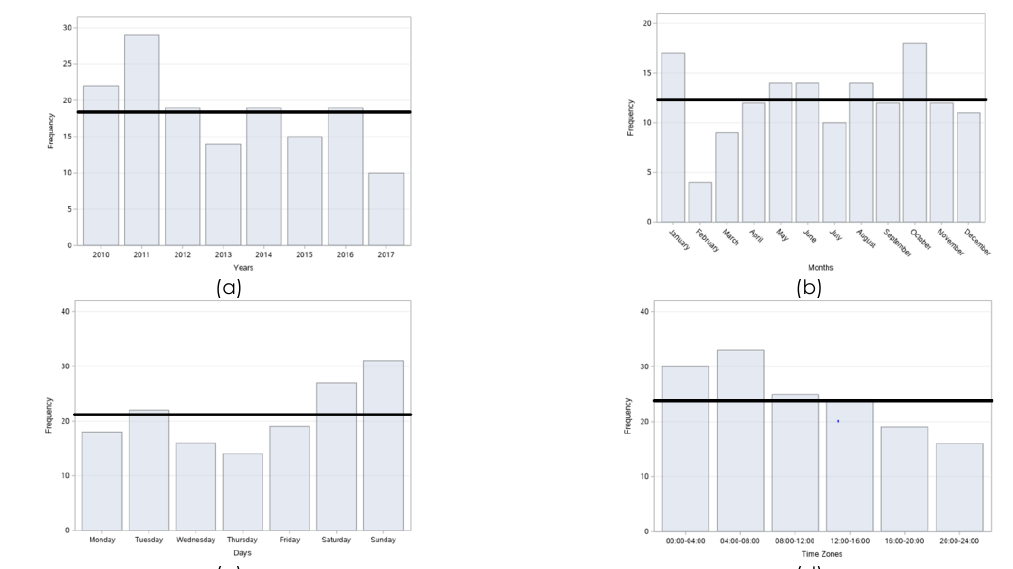
(d) By time zones.